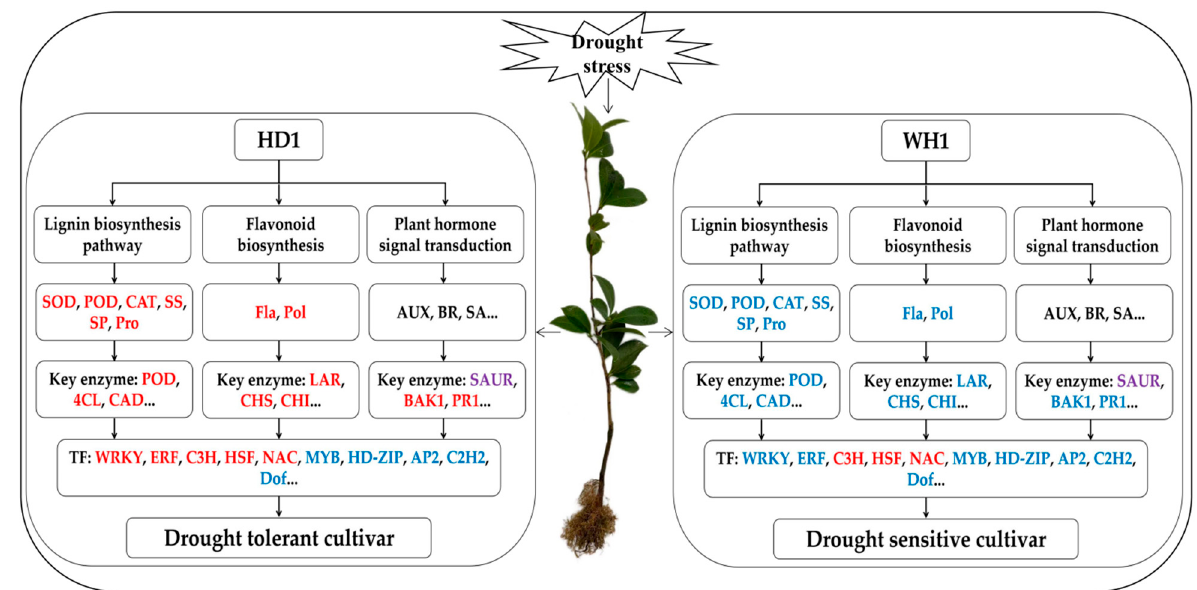
Figure 11. Schematic diagram of the molecular model of the main methods of drought resistance in C. vietnamensis seedlings of drought-tolerant and drought-sensitive cultivars under drought stress.